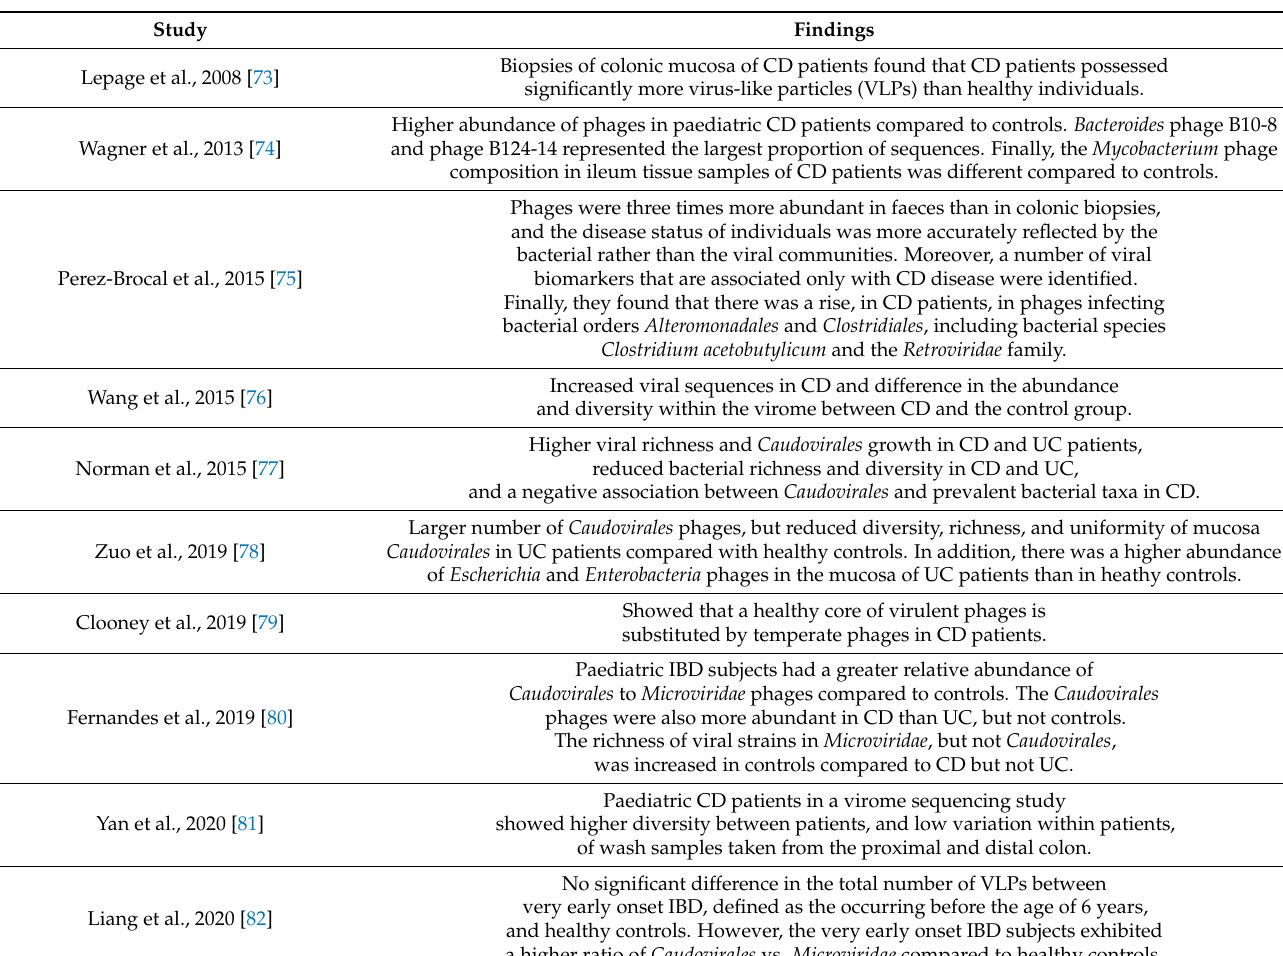
Table 4. Changes in the Hunan Gut Virome of Patients with